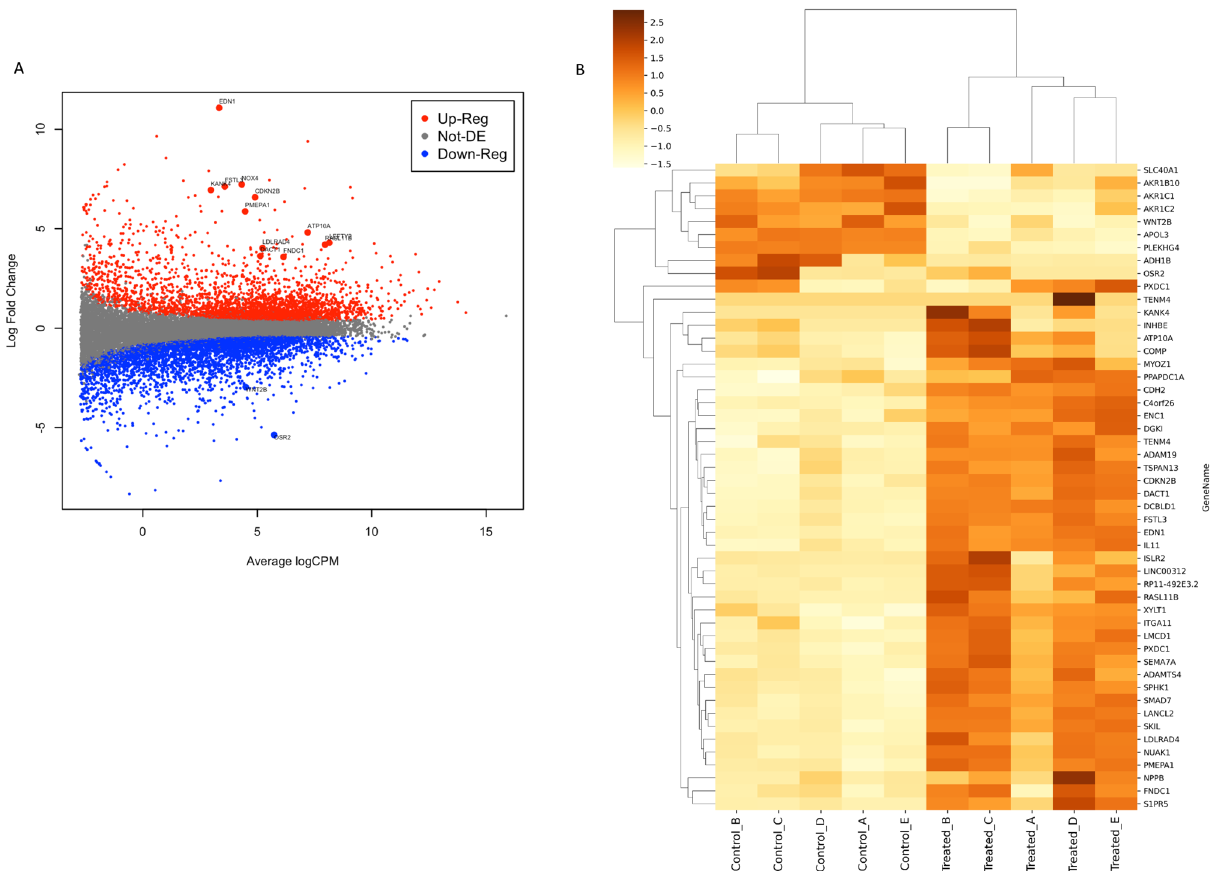
Figure 1. Gene expression analysis of TM cells treated with TGF-β2. ( A ) MA Plot showing the relationship between the LogFC and the logCPM. Red dots = significantly (p < 0.05) up-regulated genes between the two sample with a fold change(FC) > 2; Grey dots = genes were not differentially (p > 0.05) expressed between the two sample groups with a FC < 2; Blue dots = significantly (p < 0.05) down-regulated genes between the two samples with a FC > − 2. ( B ) Hierarchical clustering by sample and transcripts was performed on all samples passing the QC using the top 50 DEGs that have the largest coefficient of variation based on FPKM